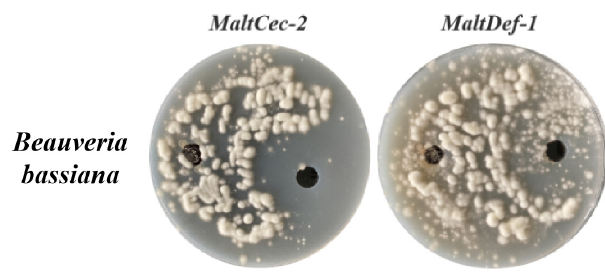
Figure 3. Antifungal circle of M. alternatus AMPs protein.